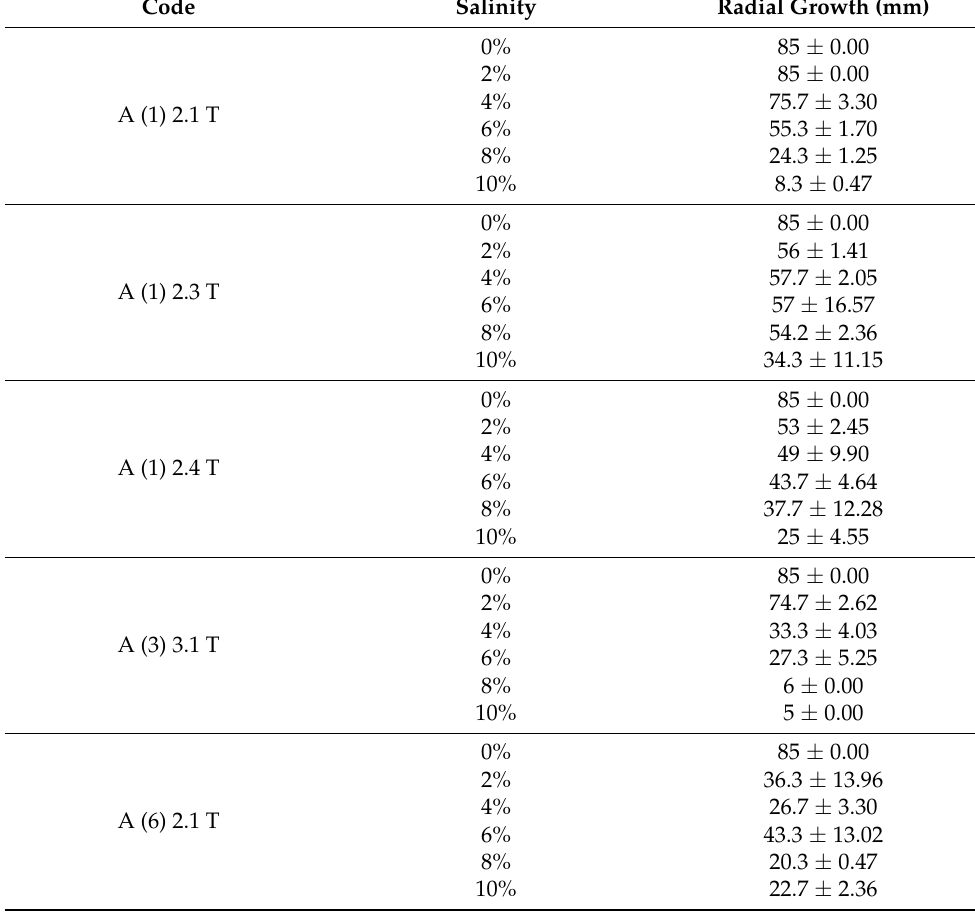
Table 5. Effect of different salt concentrations on the growth of Trichoderma